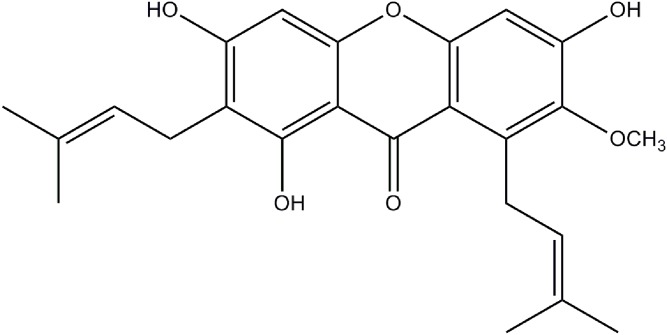
Chemical structure for αMG.Molecular formula: C24H26O6. Molecular weight: 410.466.